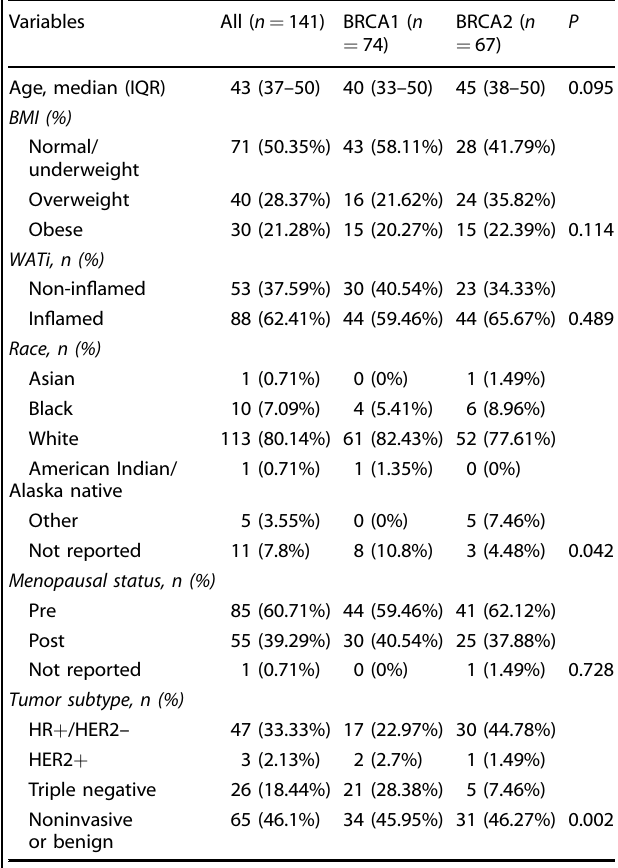
Table 1. Baseline characteristics of study population.